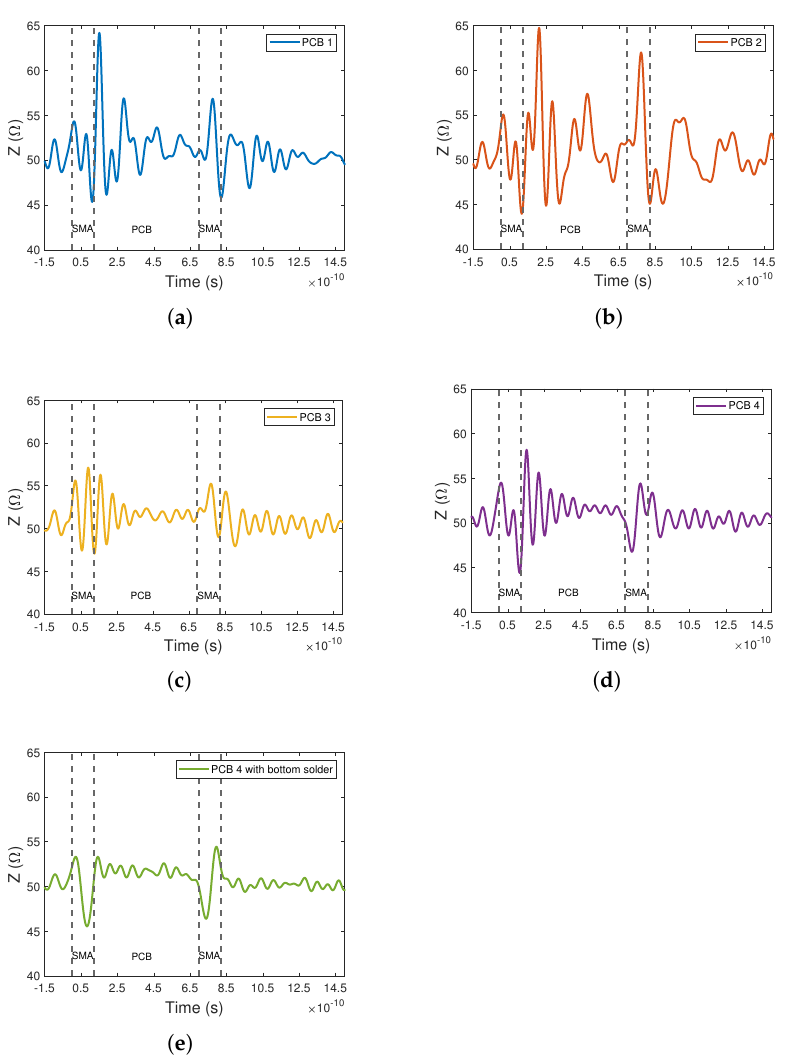
Figure 7. ( a – d ) Comparision of TDR measurements of PCB 1, PCB 2, PCB 3 and PCB 4. ( e ) TDR measurement of PCB 4 applying solder to short the PCB edge gap between the ground metal layer and the SMA connector